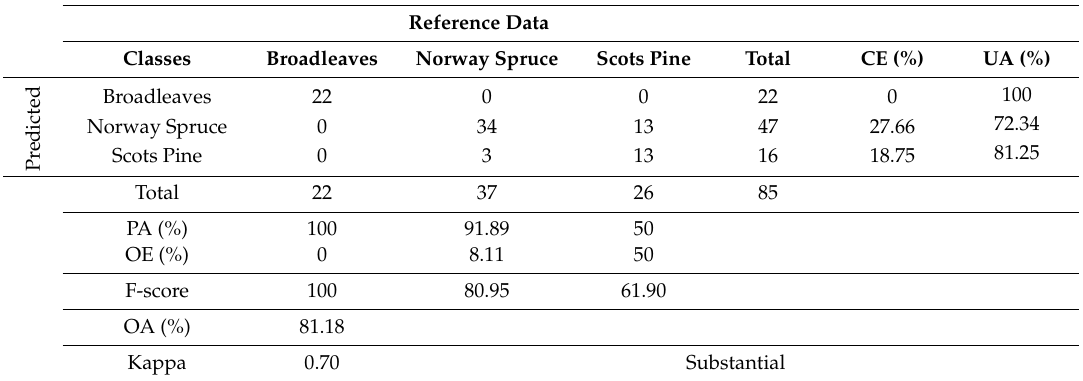
Table 5. Tree species classification summary table and confusion matrix derived from the support vector machine (SVM) analysis using a combination of VI and TA